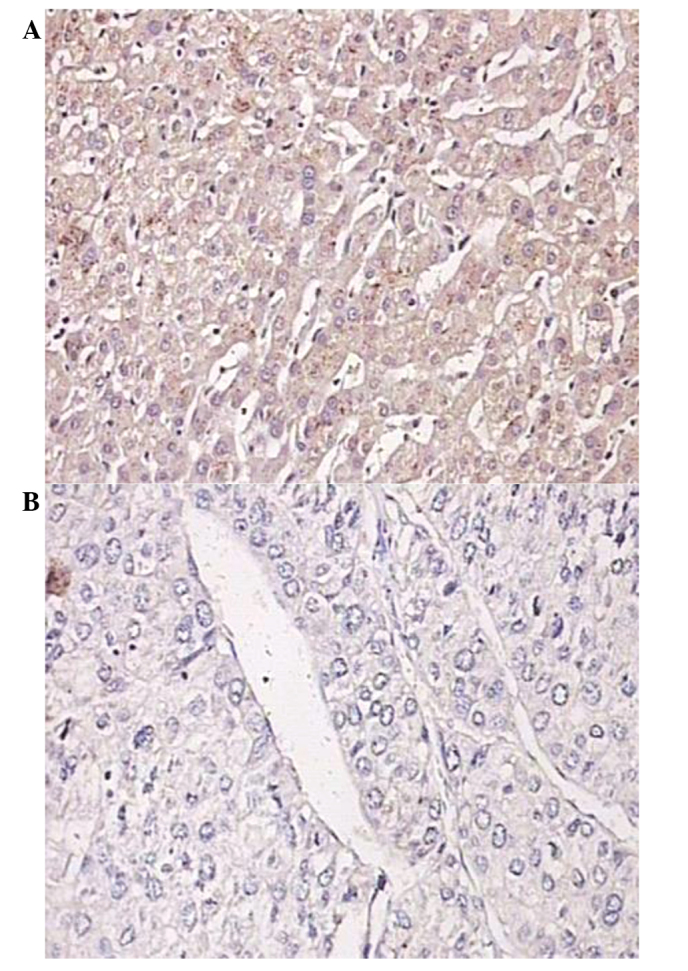
Expression of angiotensin II type 1 receptor (AT-1R) protein (magnification, ×200). (A) AT-1R is mainly expressed in the cytoplasm presenting as brown granules in normal tissue. (B) AT-1R granules are observed in PHC tissue.